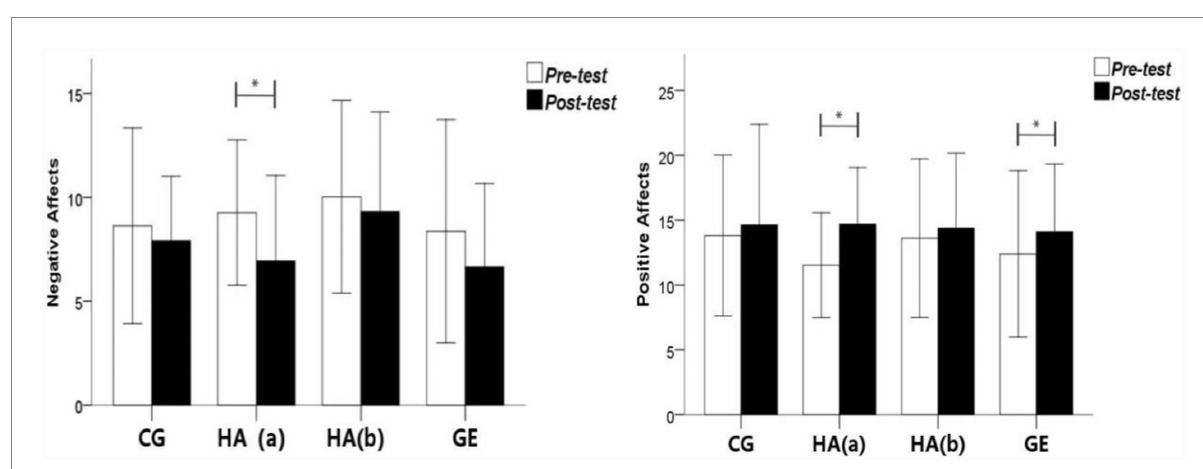
FIGURE 6 The pre-test and post-test change trends of negative affects and positive affects.